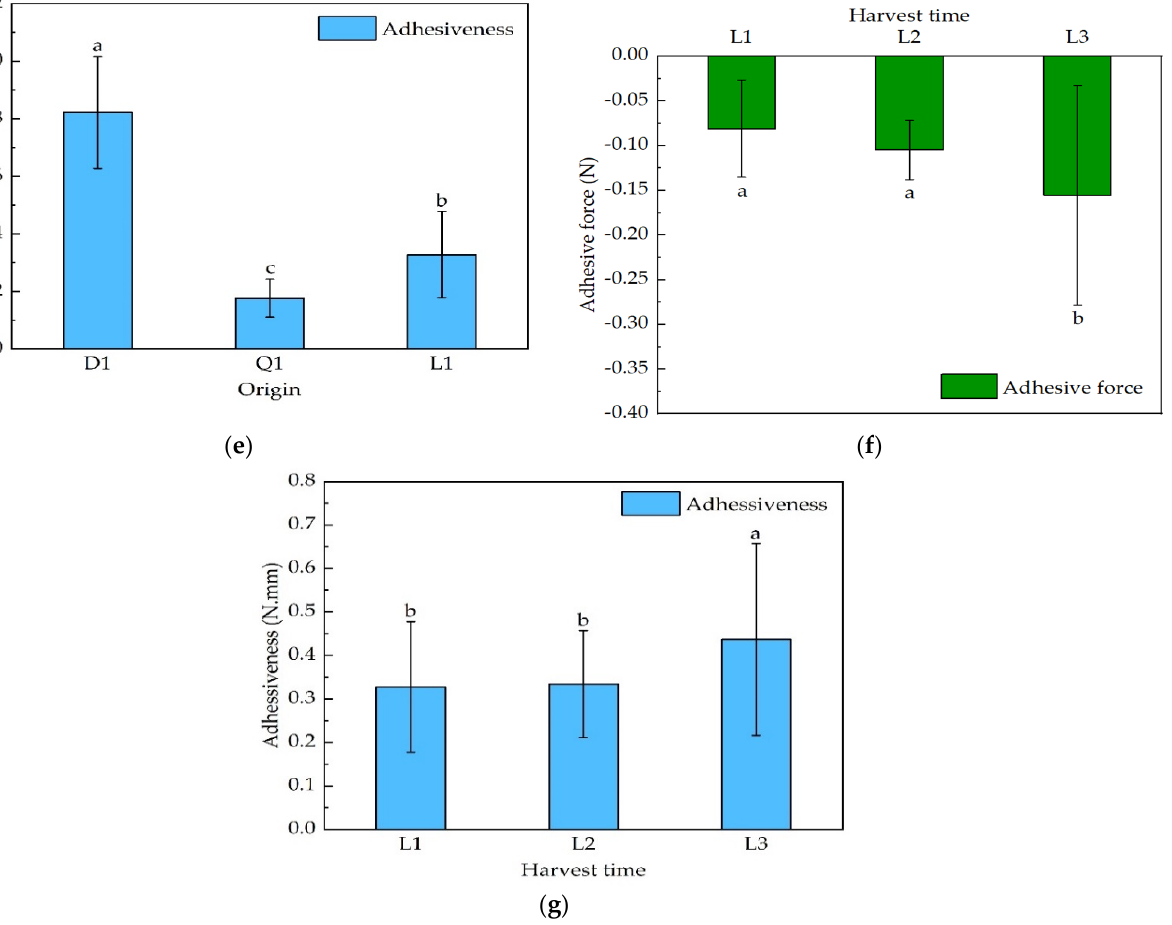
Figure 9. Adhesive force and adhesiveness properties of laver: ( a ) the load–displacement curve of the adhesive force and adhesiveness of laver; ( b ) the effect of loading rate on adhesive force; ( c ) the effect of loading rate on adhesiveness; ( d ) the effect of origin on adhesive force; ( e ) the effect of origin on adhesiveness; ( f ) the effect of harvest time on adhesive force; ( g ) the effect of harvest time on adhesiveness. The different lowercase letters indicate a significant difference between groups ( p < 0.05), while same lowercase letters indicate no significant difference between groups ( p > 0.05).